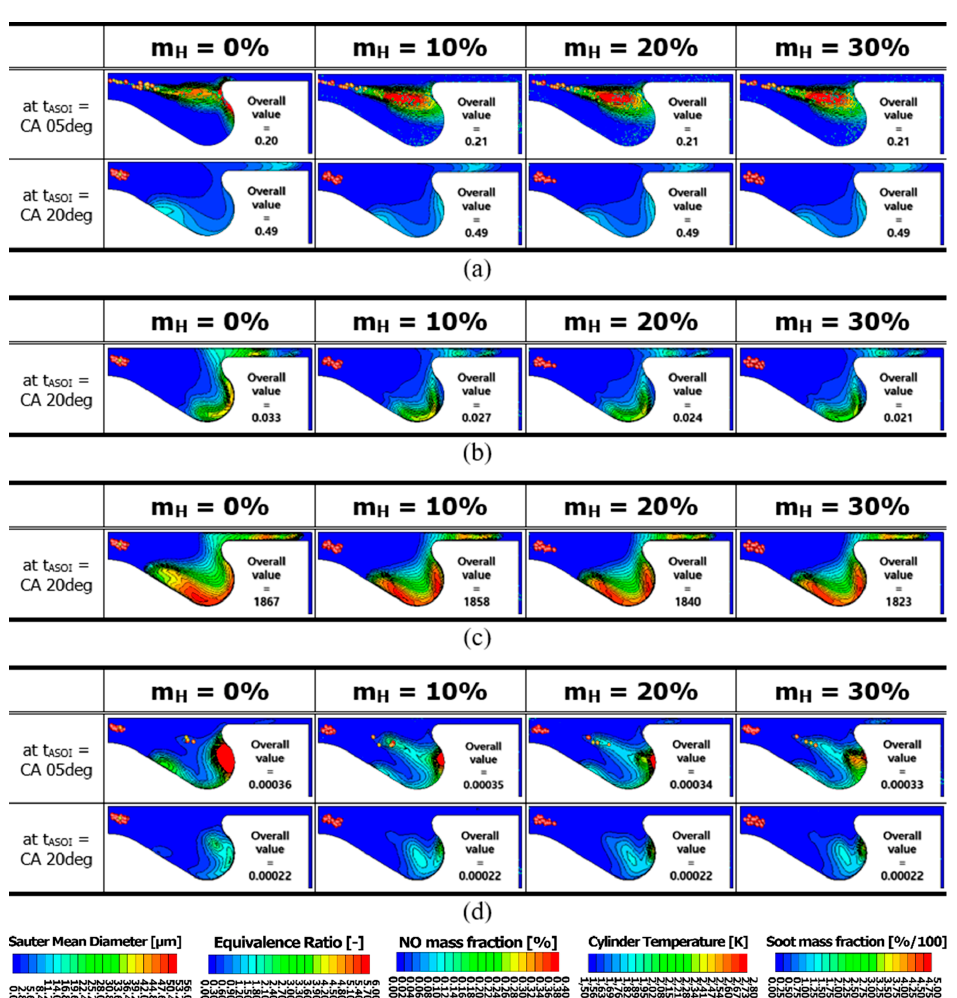
Figure 5. Effect of water vapor portion on the distributions of equivalence ratio, NO mass fraction, cylinder temperature, and soot mass fraction. ( a ) Equivalence ratio; ( b ) NO mass fraction; ( c ) cylinder temperature; and ( d ) soot mass fraction. P inj = 100 MPa, m inj = 14 mg, t eng = BTDC 15deg, 1800 rpm.